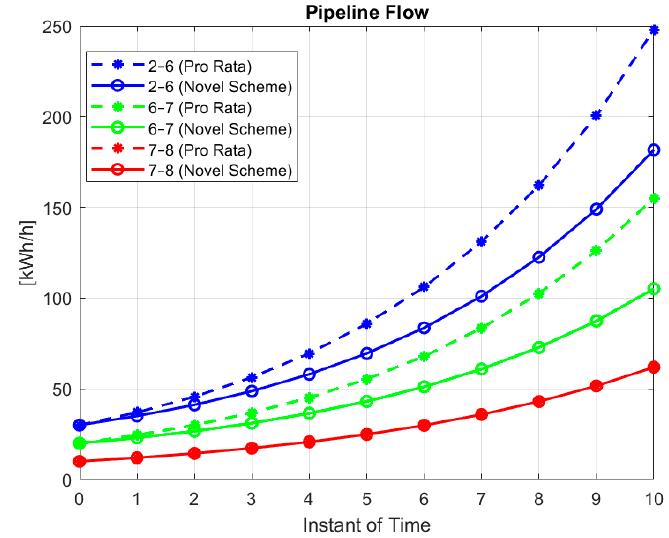
Figure 5. Pipeline network results obtained with only Pro Rata method (dashed line) and with novel scheme (full line) related to the following flows: 2–6, 6–7, and 7–8.